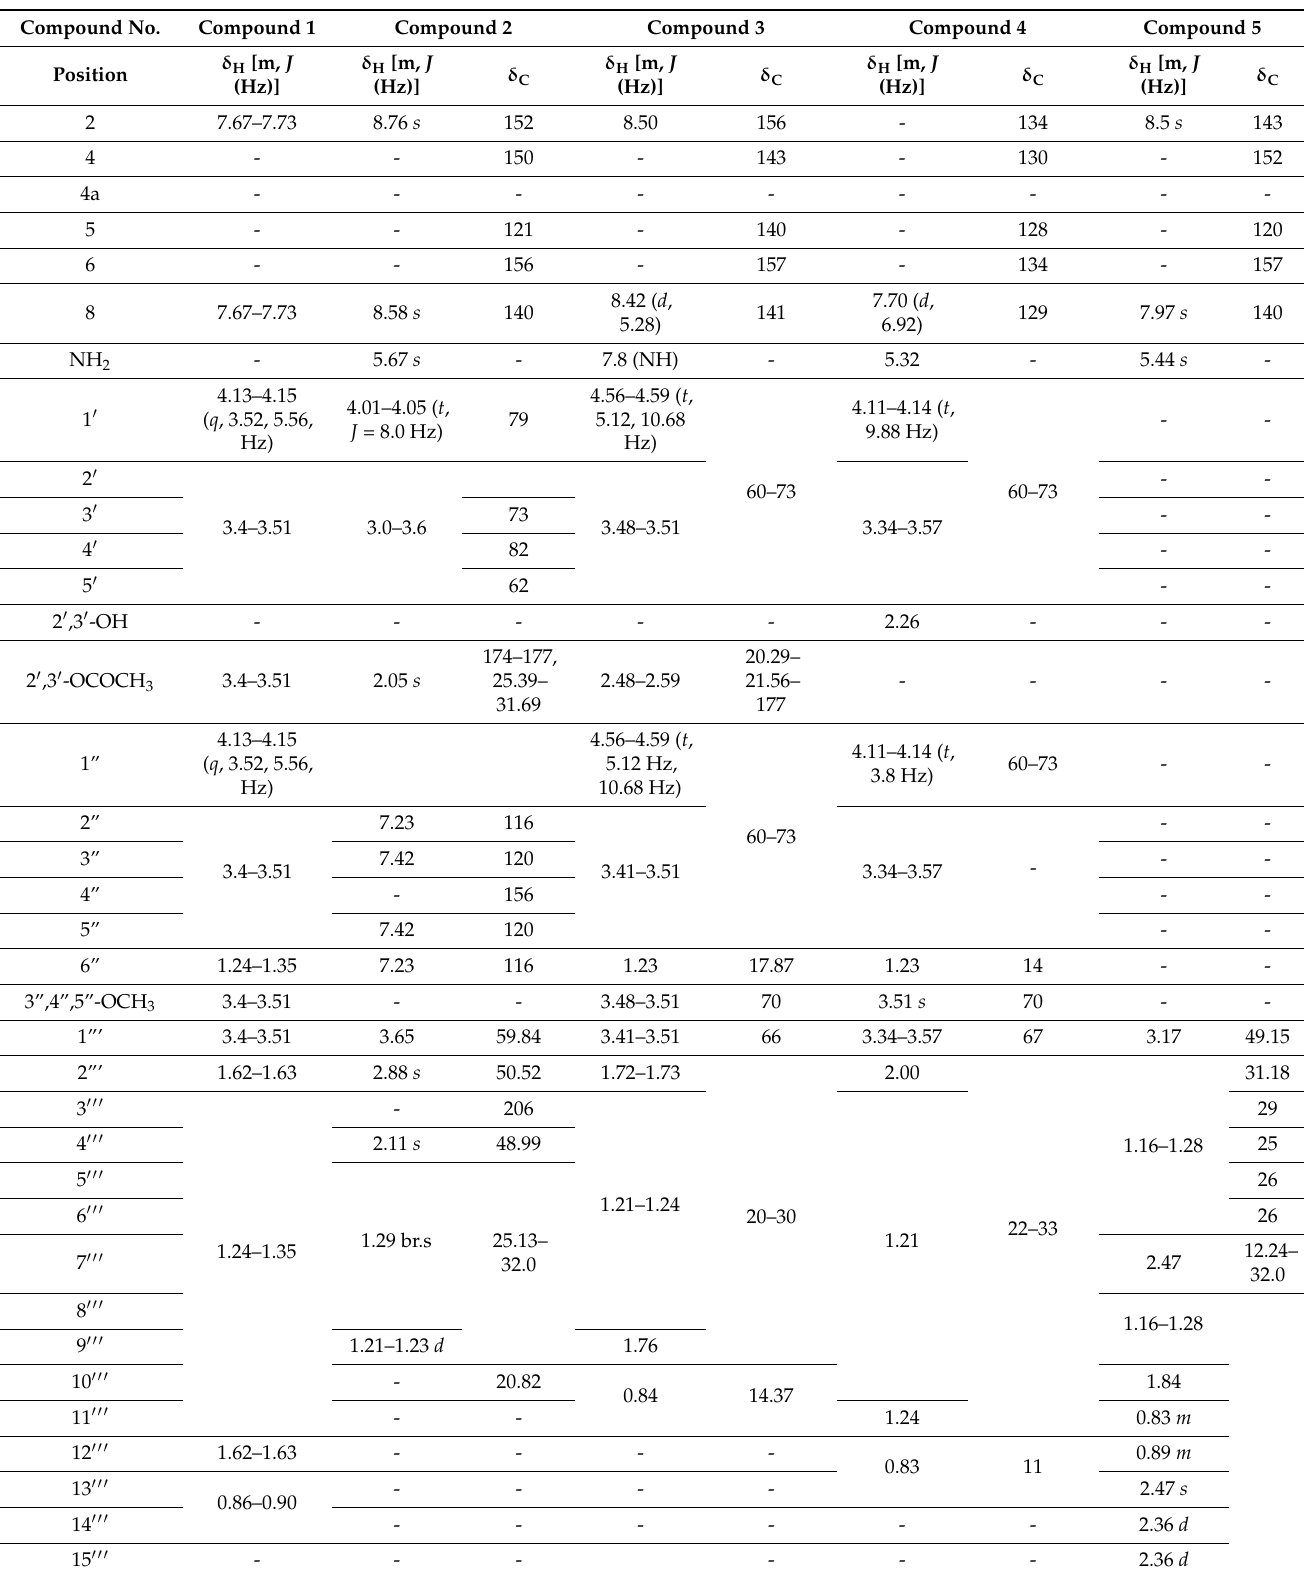
Table 1. 1 H- and 13 C-NMR data for compounds 1 – 5 (DMSO- d 6